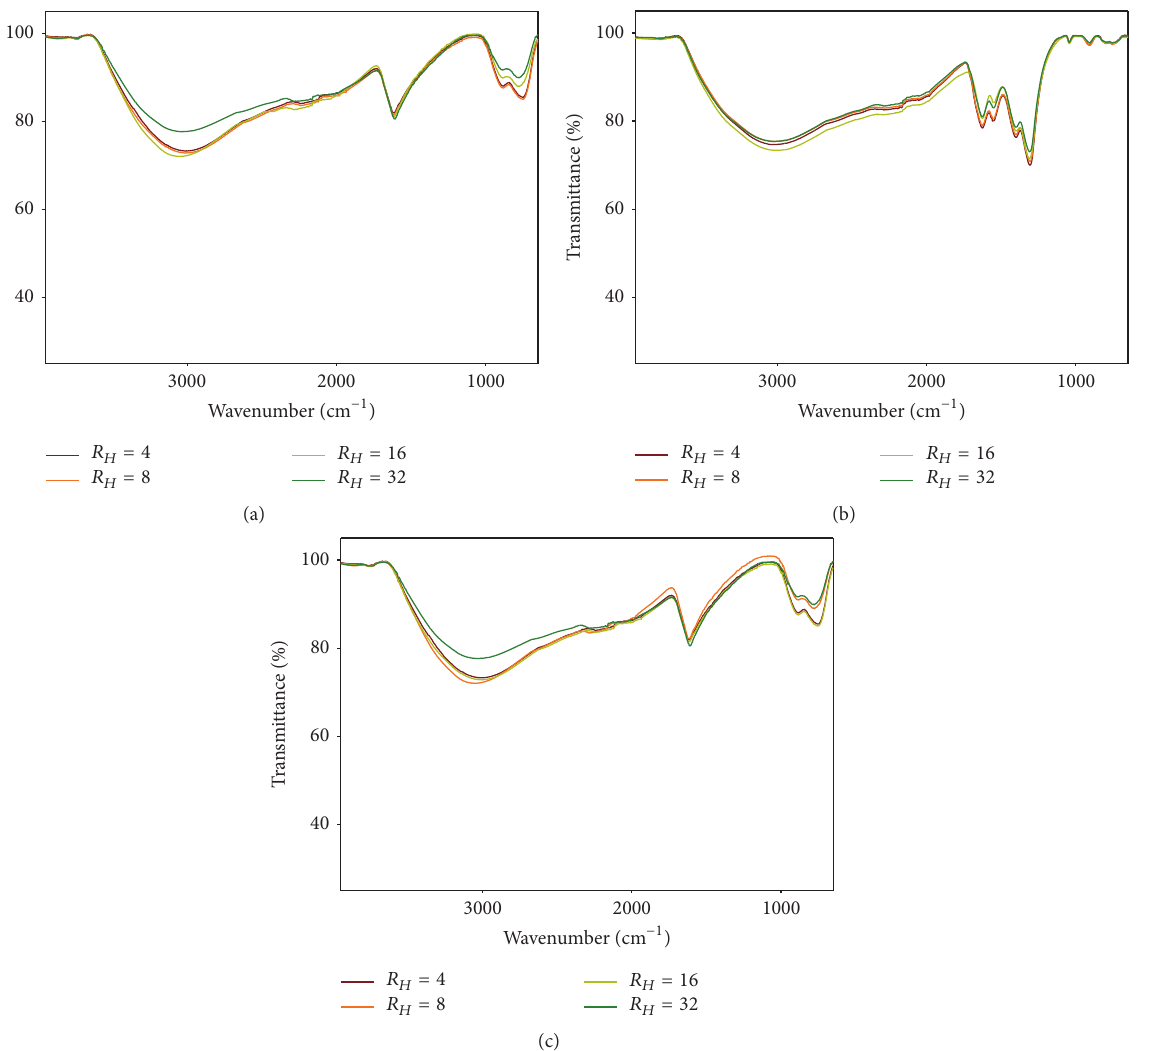
Figure 5: IR absorption spectra: (a) HCl-THF/TiO 2 , (b) HNO 3 -THF/TiO 2 , and (c) ClHNO 2 -THF/TiO 2 nanoparticles.